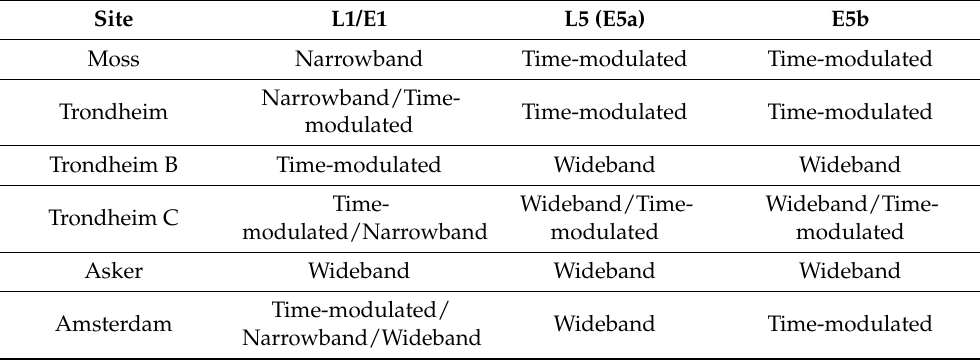
Figure 6. Detailed classification results, Amsterdam station, Netherlands, 2020. Table 2. Summary of the dominant RFI type per site for the L1/E1, E5a and E5b frequency